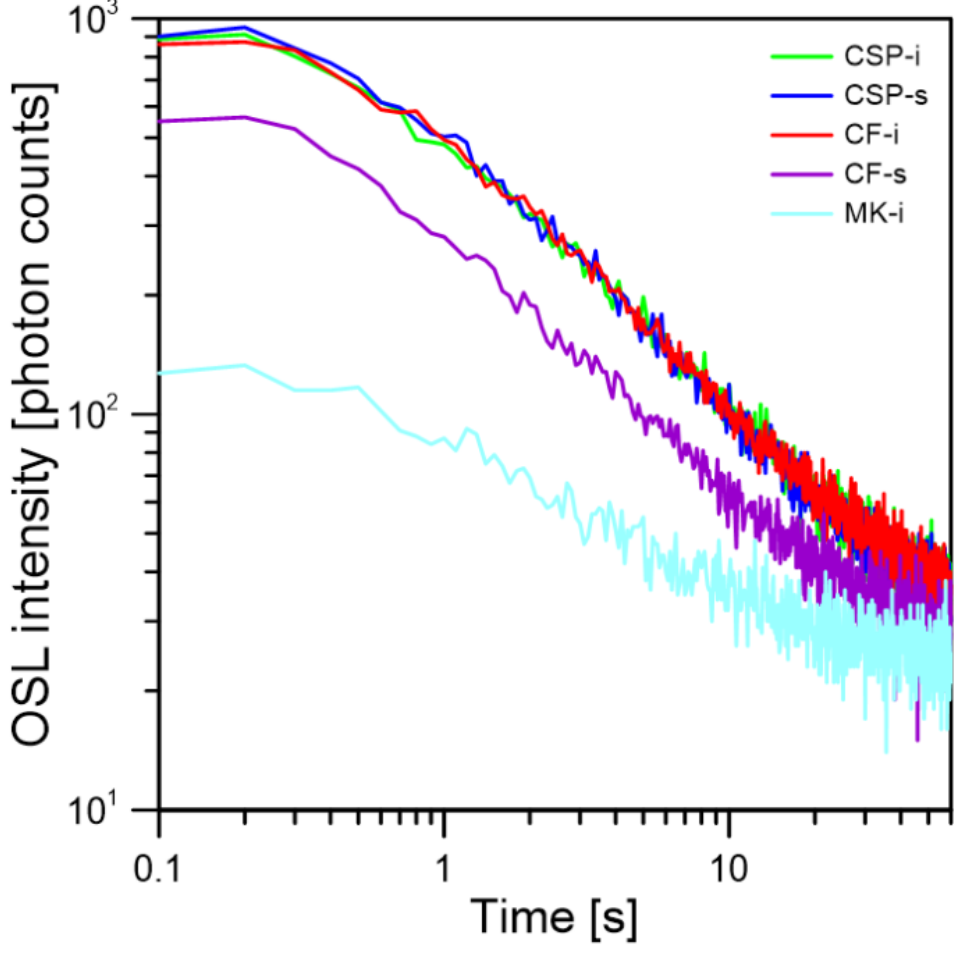
Figure 4. Comparison of the OSL decays (with the highest intensity among a given type) for the five types of samples tested, namely CSP-i, CF-i, CSP-s, CF-s, and MK-i, obtained after irradiation with a dose of 0.6 Gy.